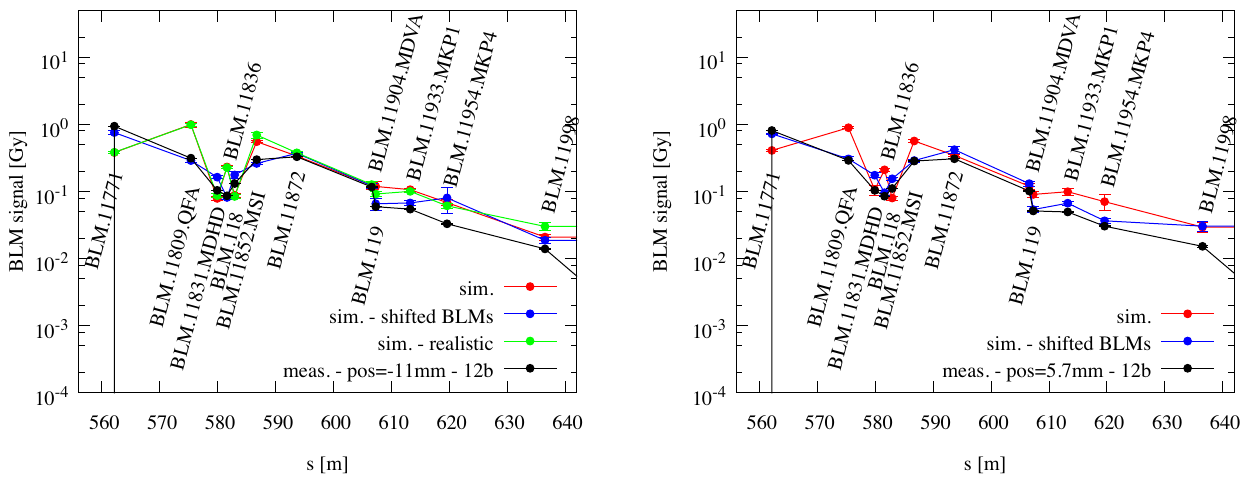
FIG. 18. Comparison between measured BLM signals (black curves) and predictions by simulations (colored curves) in LSS1, downstream of the scrapers, in case of full beam scraping with the horizontal (left frame) and the vertical (right frame) blades. Measurements with low-intensity beams are shown (see Fig. 11). The red curves show the simulation results with BLMs in their nominal positions, whereas the blue ones show the effect of a transverse displacement of the monitors in a more favorable position. The green curve shows simulation results in case more realistic assumptions are taken into account, i.e., with a broader beam distribution, the blade moving at the slower speed of 60 mm s − 1 and tilted by 4 ° about the longitudinal axis; simulations were carried out for the horizontal blade only. When visible, the error bars on the measurements refer to the LSB, whereas those on the simulated data refer to the statistical uncertainty